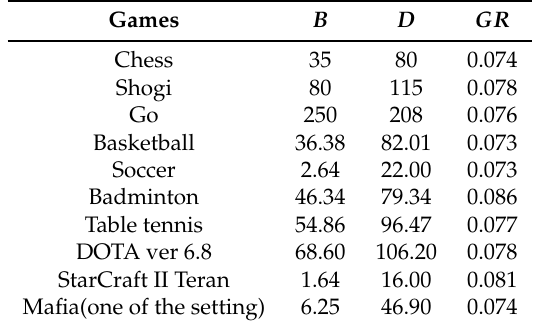
Table 1. Measure ( GR ) of game refinement for some popular games [28]. Games B D GR